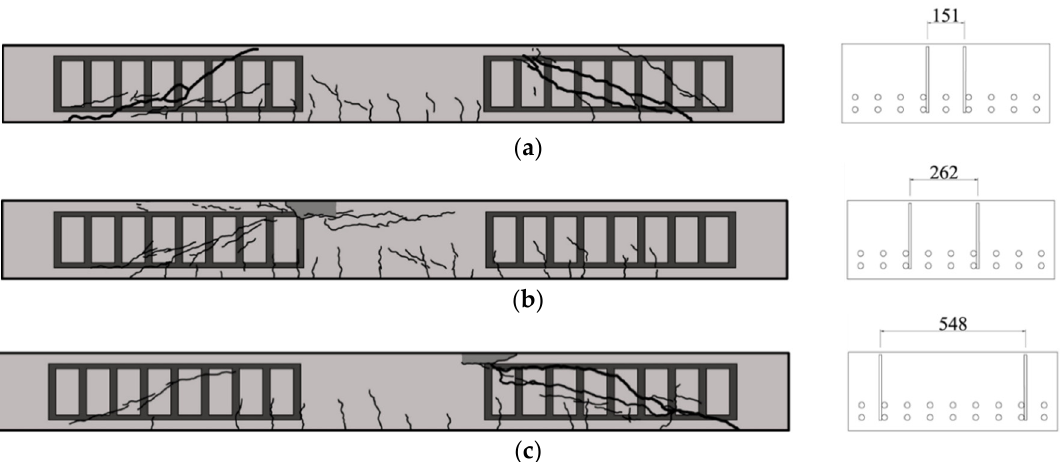
Figure 5. Crack pattern for various transverse spacing: ( a ) 1S-N151; ( b ) 1S-N262; ( c ) 1S-N548.